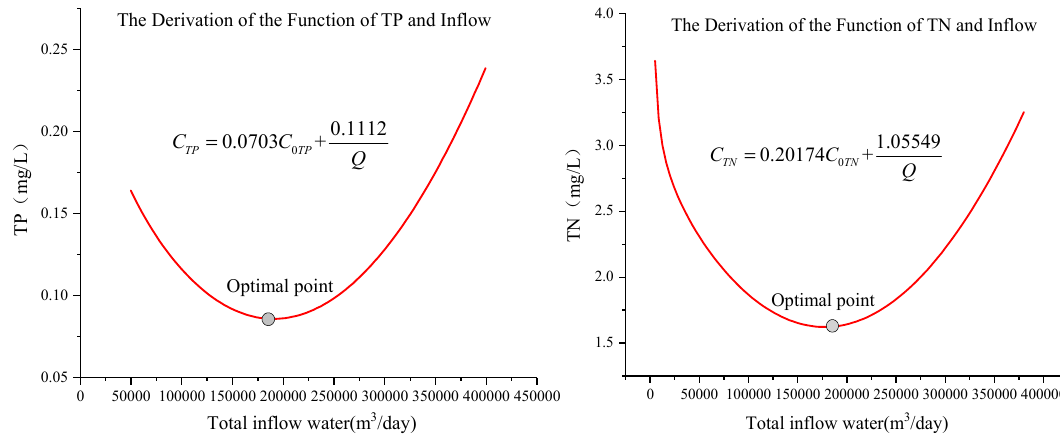
Figure 12. Relationship between diversion water quality and total inflow in Xuanwu Lake. It is clear from the figure that the water quality of Xuanwu Lake first became better and worse after the increase of the flow rate, and the optimal flow rate was 180,000 m 3 /day. At the same time, we can also see from the derivation function that the water quality of Xuanwu Lake has a relationship with the water quality and flow of the diversion water. The water quality of Xuanwu Lake had a positive correlation with the water quality of diversion water, and it had a negative correlation with the inflow discharge of diversion water. When the inflow discharge is less than 180,000 m 3 /day, the volume of water diversion will play a leading role in the water quality of Xuanwu Lake. However, when the water diversion volume is greater than 180,000 m 3 /day, the water quality of diversion will play a dominant role in the water quality of Xuanwu Lake.